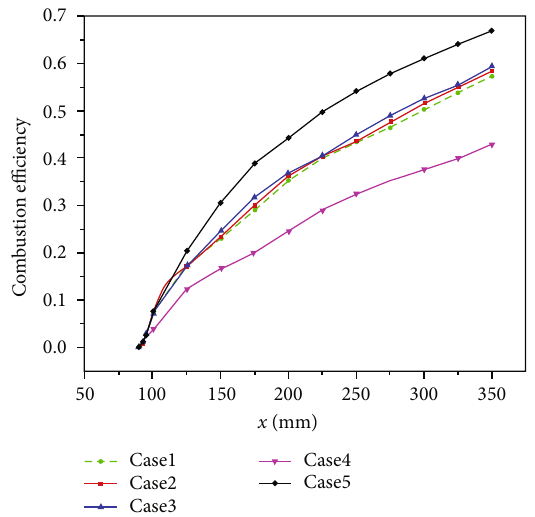
Figure 31: The distribution of the combustion e ffi ciency for di ff erent